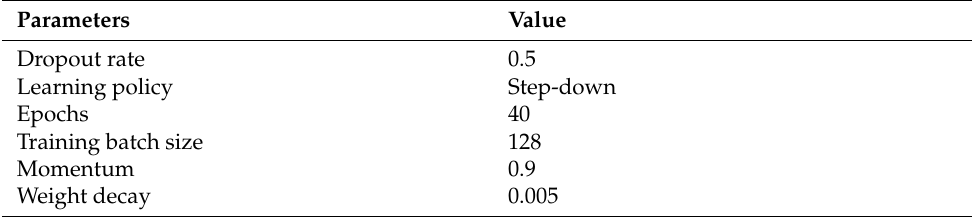
Table 1. The parameters for AlexNet.